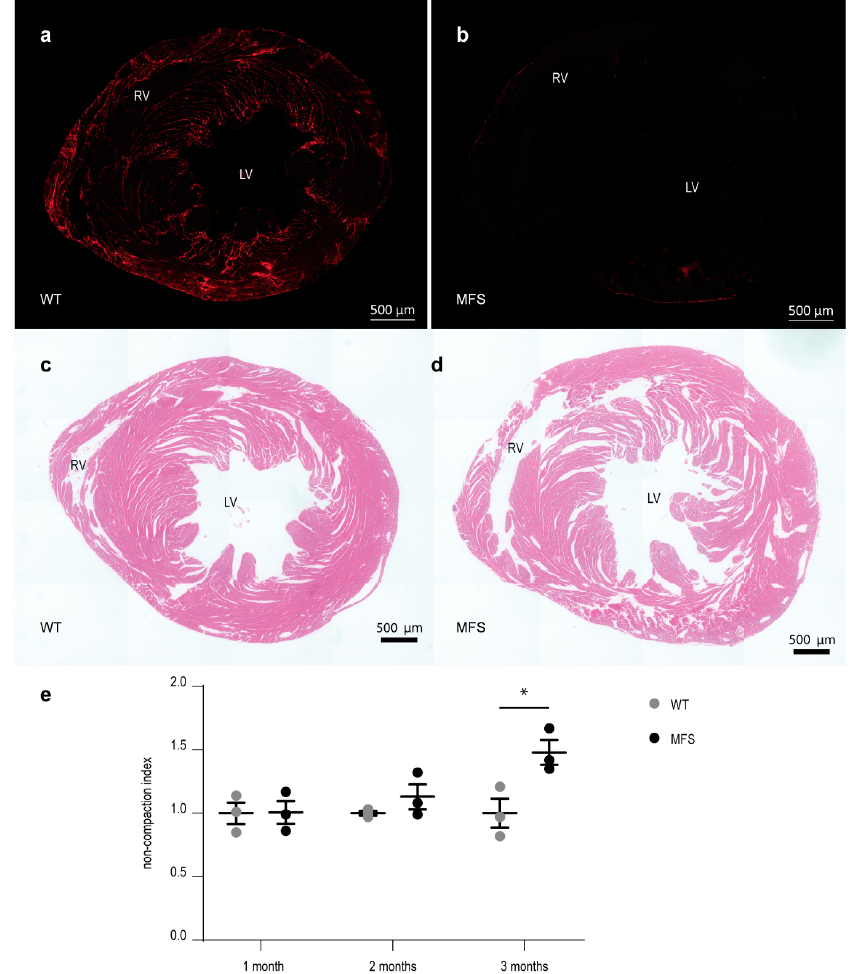
Figure 4. Decreased compaction of the ventricular myocardial tissue in MFS mice correlates with a decreased presence of fibrillin-1 staining. ( a , b ): overview picture of fibrillin-1 (red) staining of myocardial tissue sections of a 3-month-old WT and MFS mouse, respectively. ( c , d ): representative overview pictures of HE-stained myocardial tissue sections of a 3-month-old WT and MFS mouse, respectively. ( e ): graphical presentation of the myocardial compaction level through the measurement of the average non-compaction index of the myocardial tissue sections ( n / age group = 3). Within each age group, values are normalized to the WT values. WT and MFS measurements are indicated in grey and black, respectively. Error bars represents standard error. * p = 0.032 (independent samples test). RV, right ventricle; LV, left ventricle; WT, wild-type; MFS, Marfan syndrome. Scale bar = 500 µ